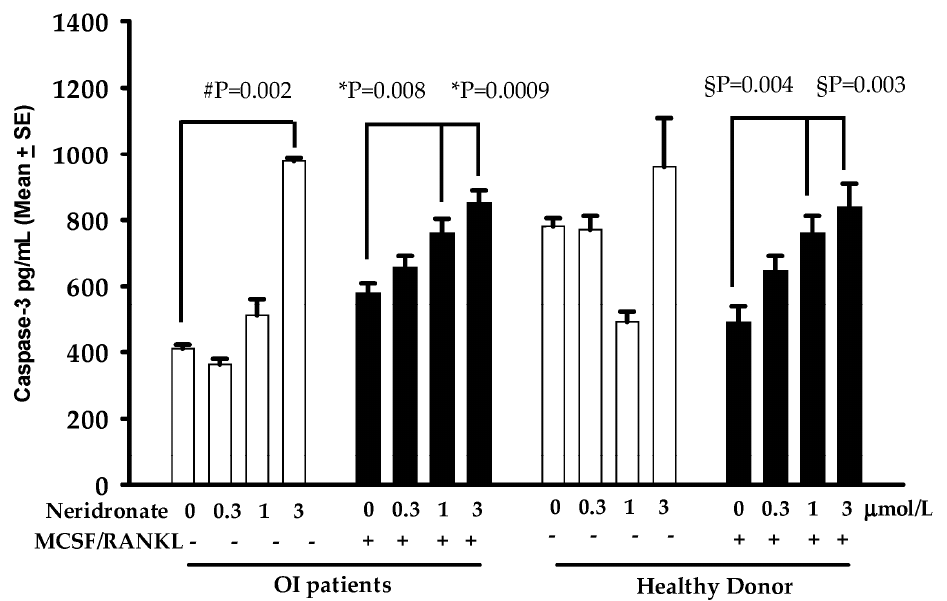
Figure 3. Caspase-3 levels in media of osteoclast cultures from a representative OI patient and a representative healthy donor treated with different concentrations of neridronate. Each treatment was performed in quintuplicate replication, and each bar reports the results as mean ± SE. #, * and § are referred to as 0 neridronate.